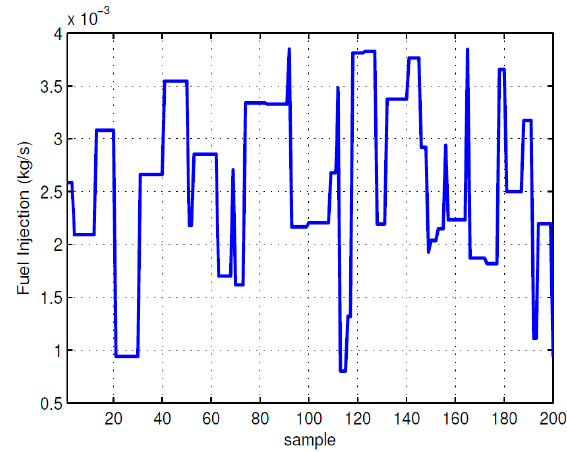
Figure 4. RAS for the fuel injection rate.